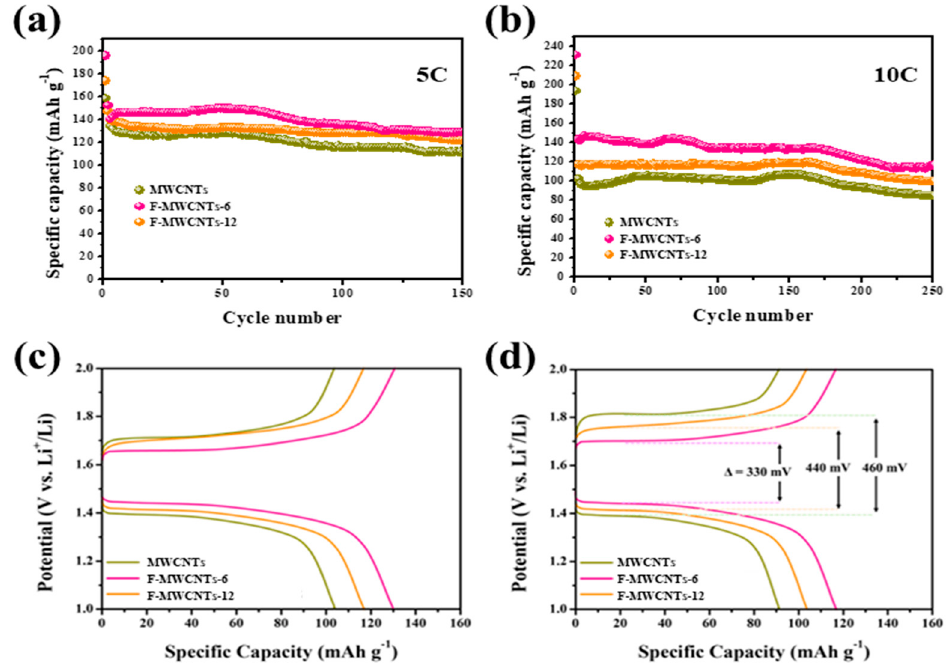
Figure 4. Cycling performance of LTO with added MWCNTs, F-MWCNTs_6 and F-MWCNTs_12 at ( a ) 5 and ( b ) 10 C. The corresponding ( c ) 100th and ( d ) 200th galvanostatic charge/discharge curves of LTO with added MWCNTs, F-MWCNTs_6 and F-MWCNTs_12.